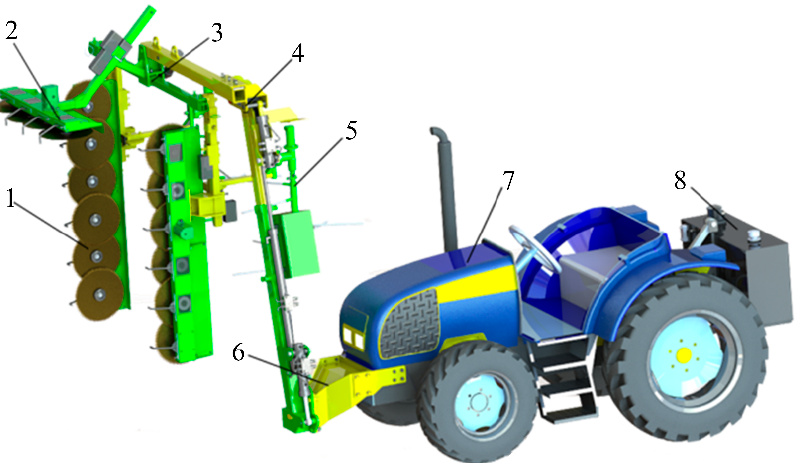
Figure 2. Pruning machine for jujube trees. (1) Side pruning assembly. (2) Top pruning assembly. (3) Shaping and pruning frame. (4) Shaping and adjusting frame. (5) Removal mechanism for jujube hangings. (6) Connecting seat. (7) Tractor. (8) Hydraulic system.